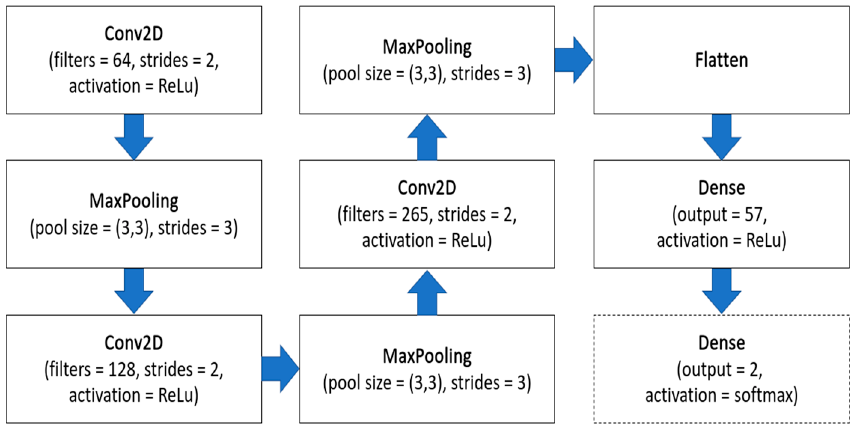
Figure 3. The architecture of the CNN used in the research. In dashed lines, the added Dense network was in solely a CNN-based approach.